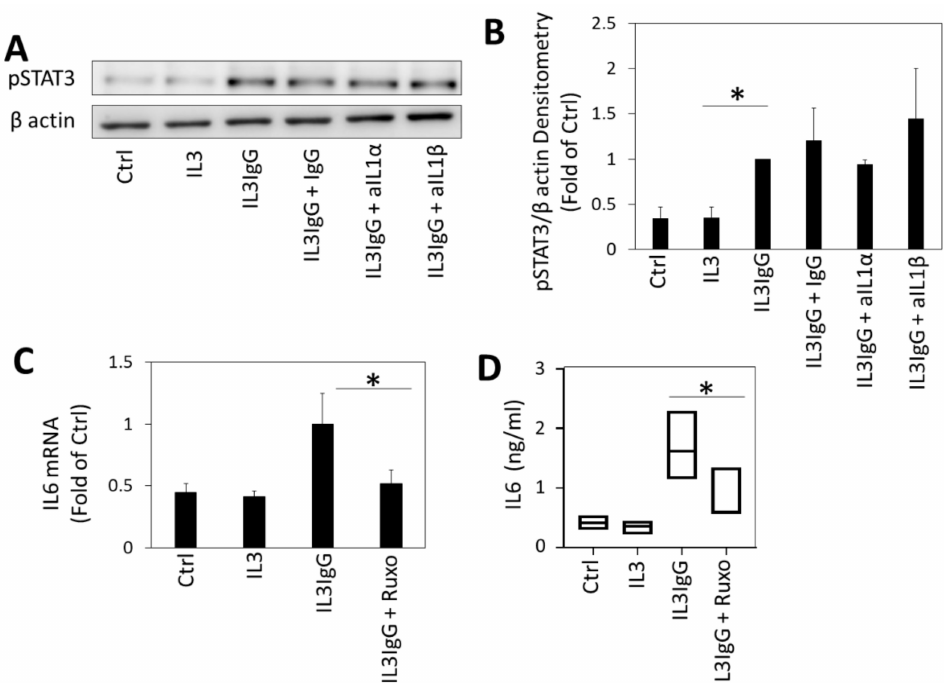
Figure 6. Eosinophil-derived supernatants lead to the production of IL6 by HBF through the IL1- independent Janus Kinase (JAK)/Signal Transducer and Activator of Transcription Protein (STAT) signaling mechanism. ( A ) IL3IgG supernatants were incubated for 1 h with either IgG control antibody (1 µ g/mL), IL1 α neutralizing antibody (aIL1 α , 1 µ g/mL) or IL1 β neutralizing antibody (aIL1 β , 1 µ g/mL) prior to stimulation of HBF. HBF were alternatively incubated with basal medium (Ctrl), IL3 or IL3IgG eosinophil supernatants as a control. Thirty minutes after stimulation, HBF protein lysates were obtained and subjected to SDS-PAGE and Western blotting with indicated antibodies. ( B ) Densitometry of Western blots from A. ( n = 3 for all conditions) was done in ImageJ (mean ± sd). C-D. HBF were treated with Janus-associated kinase (JAK) inhibitor (100 nM ruxolitinib (Ruxo)) or vehicle (ethanol) prior to stimulation with eosinophil supernatants for 24 h. mRNA levels of IL6 in HBF ( n = 3 for all conditions) were assessed via RT-qPCR ( C ). Levels of IL6 in HBF supernatant ( n = 3 for all conditions) were assessed via ELISA ( D ). Unpaired ( B , C ) or paired ( D ) Student’s t -test was used to test for statistically significant differences (* p <